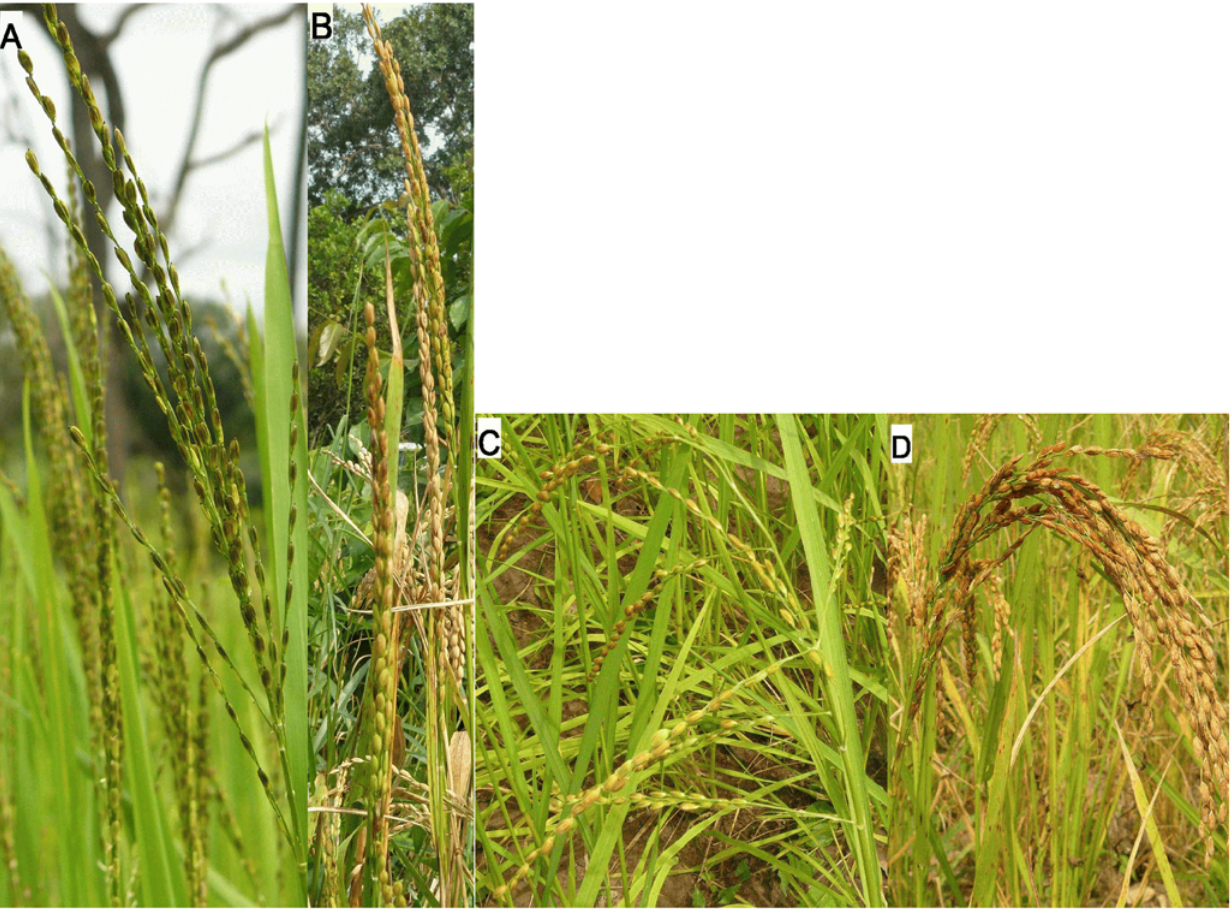
Figure 3. Main panicle types found in this study. Panicle stature of O. glaberrima (A), interspecific hybrids from sub-cluster 4-1 with erect (B) and intermediate (C) panicles respectively, and O. sativa and interspecific hybrids from sub-cluster 4-2 (D).